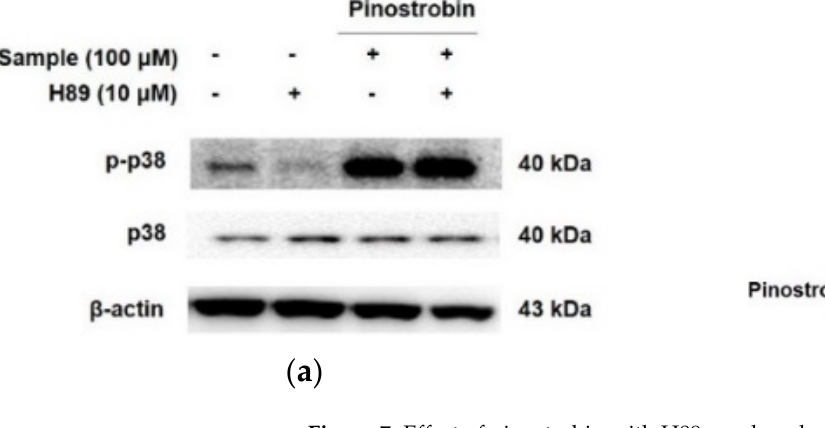
were pre − treated with H89 for 30 min prior to exposure pinostrobin (100 µM) for 24 h and then